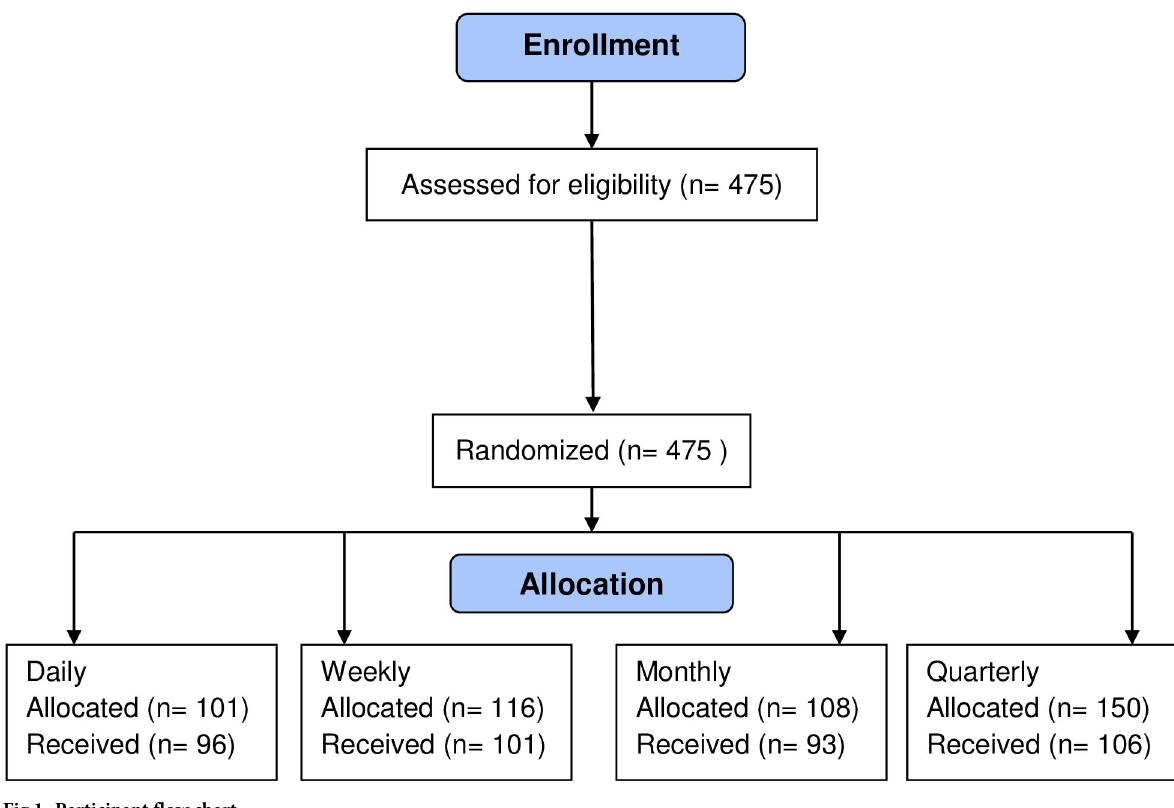
Fig 1. Participant flow